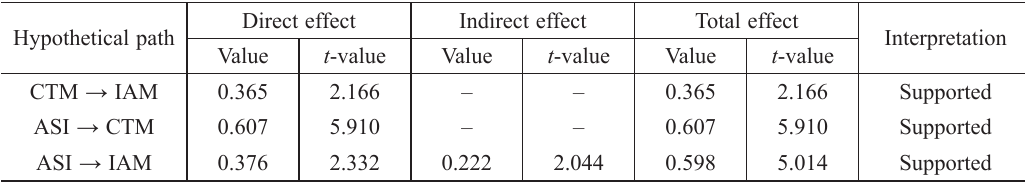
Table 8. Evaluation of